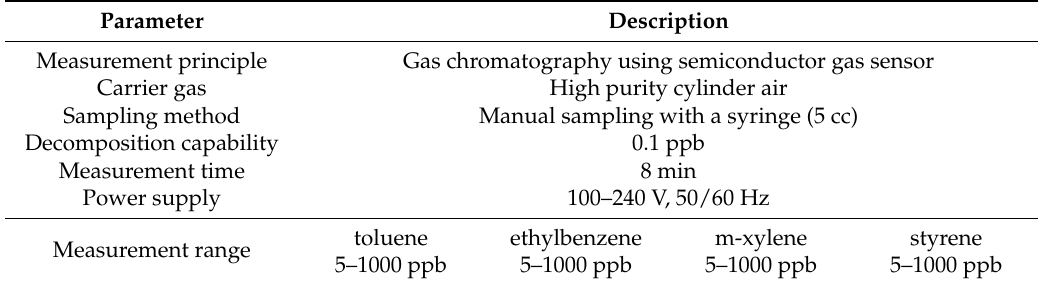
Table 3. Specifications of volatile organic compounds (VOC) analyzer